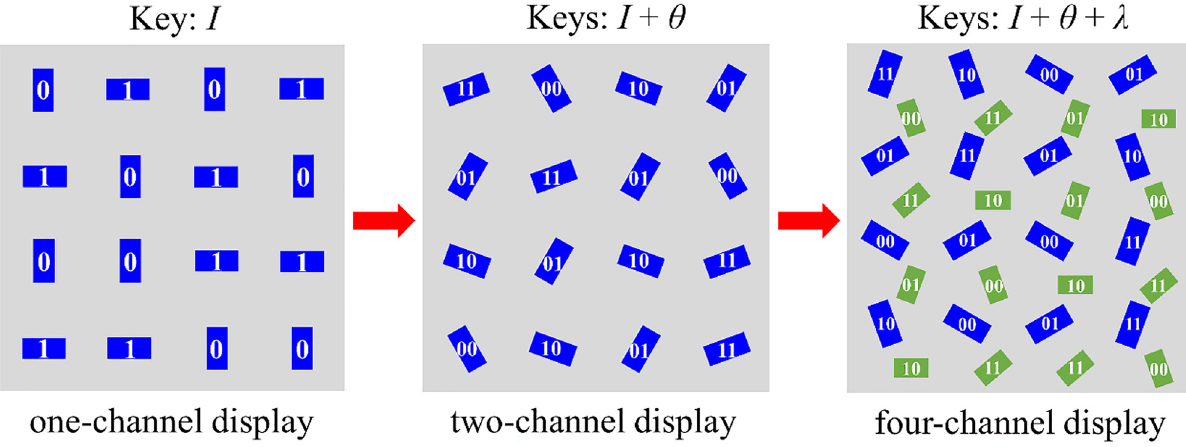
Figure 5: Design principle of four-channel display metasurface and the corresponding intensity, polarization, and wavelength encoded